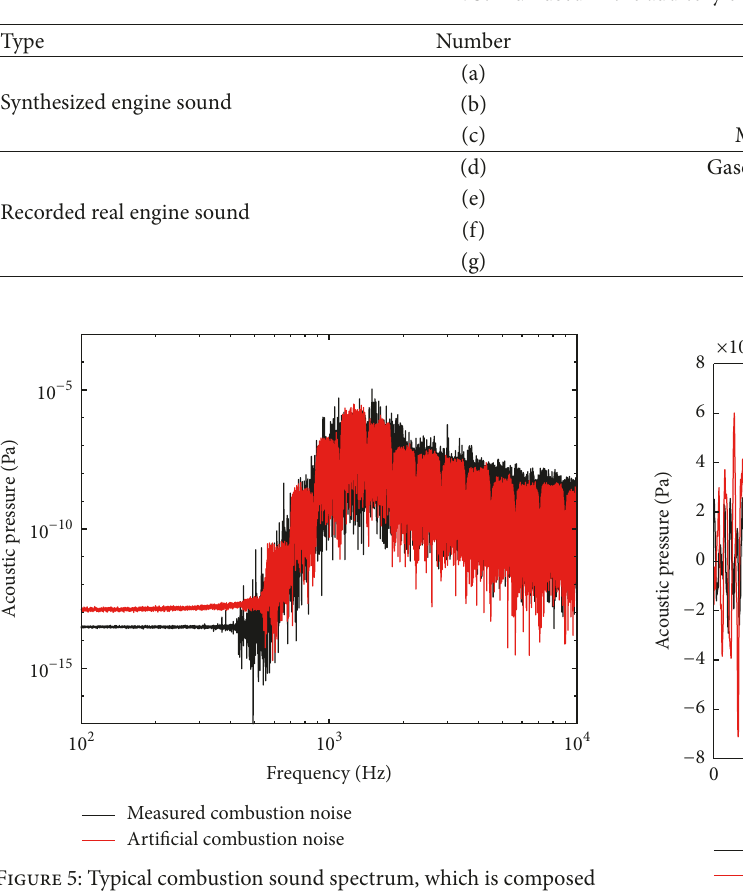
Figure 5: Typical combustion sound spectrum, which is composed of magnitude-adjusted noise bands from sampled white noise with 1/3-octave band.